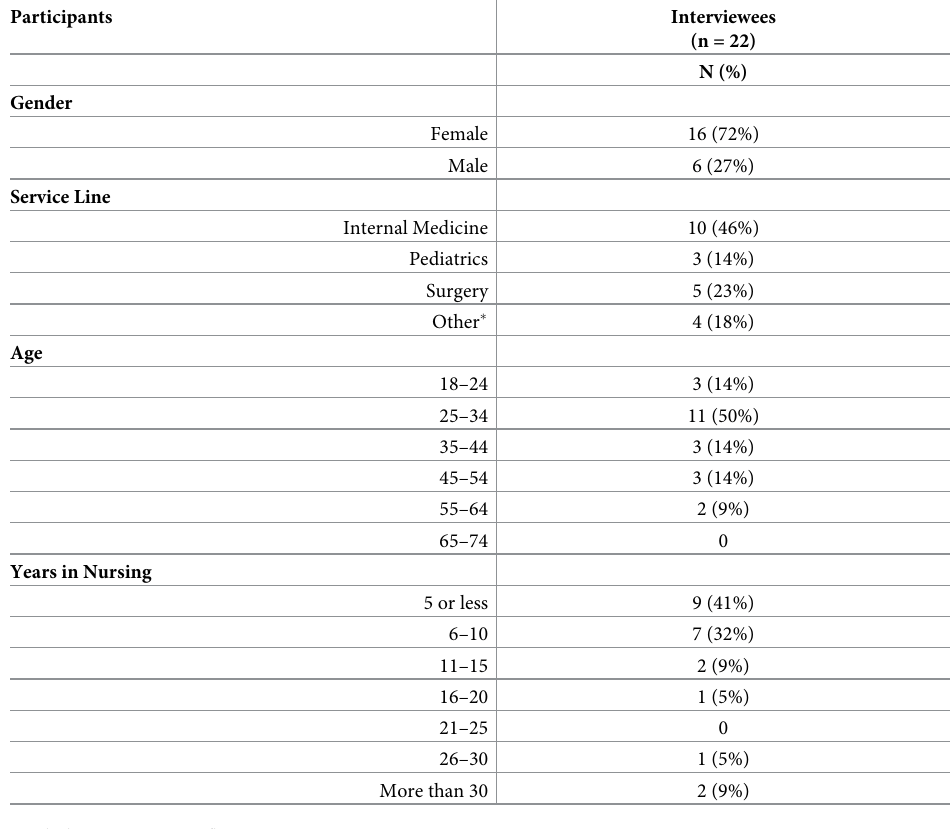
Table 1. Demographic characteristics of interview